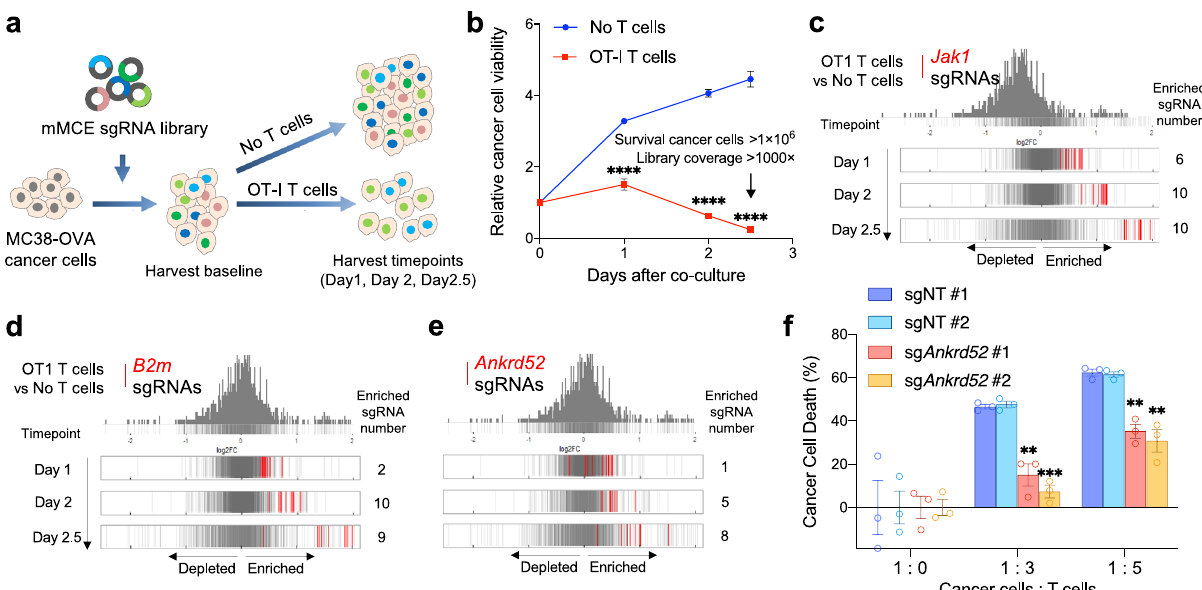
Fig. 3 Targeted in vitro CRISPR screen identi fi es ANKRD52 as a direct modulator of cancer sensitivity to T cell cytotoxicity. a Schematic overview of CRISPR screen using co-culture of OT-I T cell with MC38-OVA cells. b Cell viability of MC38-OVA cells co-cultured with OT-I T cells during 2.5 days ( n = 3 per group per timepoint). Data are represented as mean ± s.d., **** P < 0.0001, signi fi cance is determined using multiple two-tailed Student ’ s t -test. c – e Distribution histograms of log 2 FC values for all ten sgRNAs targeting Jak1 ( c ), B2m ( d ), or Ankrd52 ( e ) (Cut-off: FC > 1.4, P < 0.05 for enrichment, analyzed by edgeR). f Killing of MC38-OVA cells with indicated sgRNAs by OT-I T cells at indicated ratio in co-culture. Data are representative of three independent experiments and represented as mean ± s.e.m., ** P < 0.01, *** P < 0.001, signi fi cance was determined using multiple two-tailed Student ’ s t -test (sgNT #1 vs sg Ankrd52 #1, P = 3.72×10 − 3 for 1:3, P = 1.74×10 − 3 for 1:5; sgNT #2 vs sg Ankrd52 #1, P = 3.64×10 − 3 for 1:3, P = 1.67×10 − 3 for 1:5; sgNT #1 vs sg Ankrd52 #2, P = 2.28 × 10 − 4 for 1:3, P = 4.43 × 10 − 3 for 1:5; sgNT #2 vs sg Ankrd52 #2, P = 2.7 × 10 − 4 for 1:3, P = 4.57 × 10 − 3 for 1:5). See also Supplementary Figs. 6 and 7. Source data are provided as a source data fi